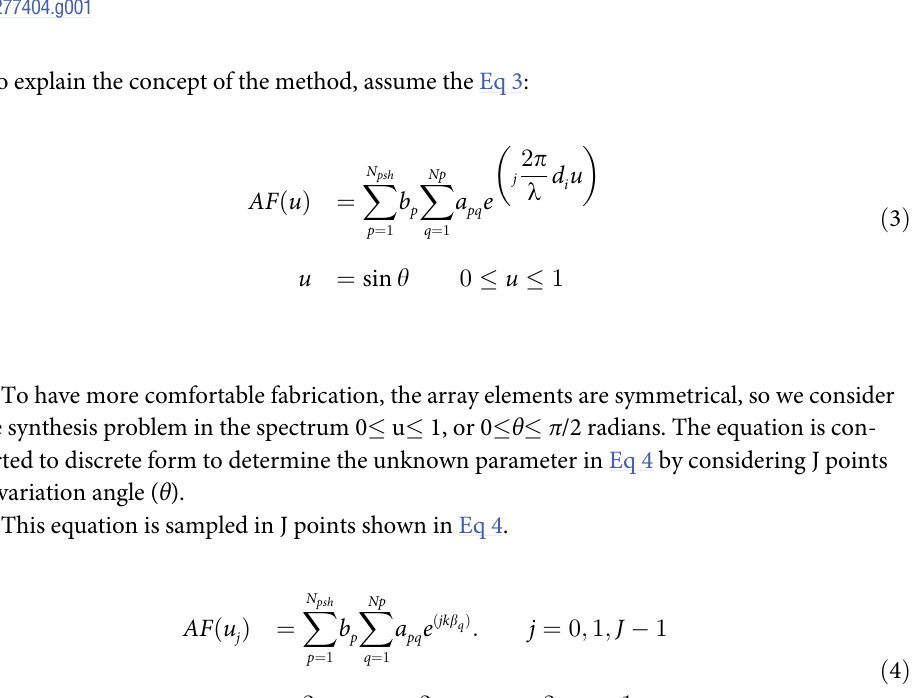
Fig 1. Show parameter N for different topologies. a. Uniform Subarray, b. Uniform Overlap Subarray, c. Random Subarray and d. Random Overlap x Subarray.